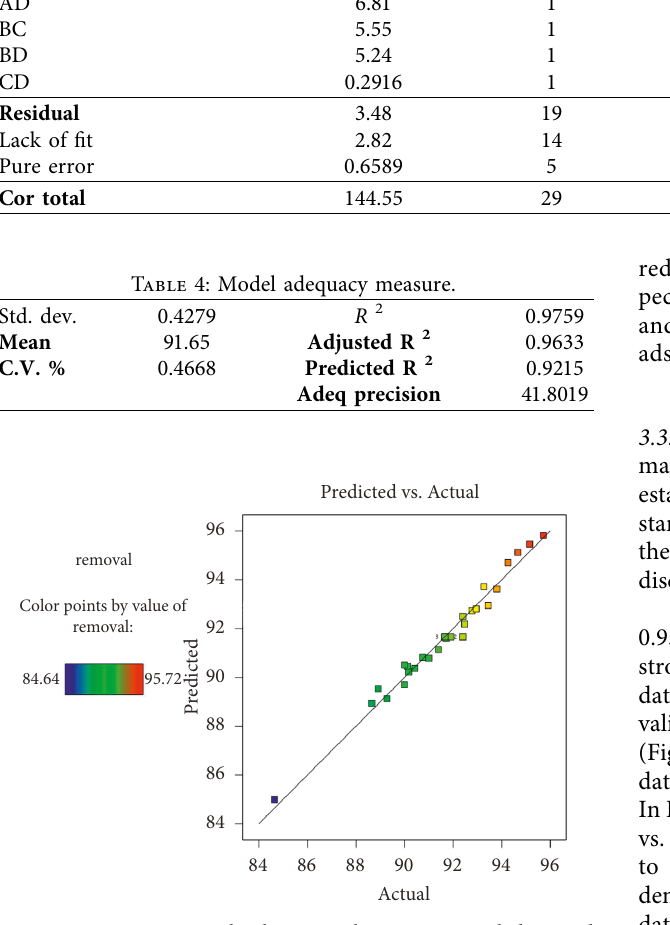
Figure 3: Comparison plot between the experimental data and predicted data for